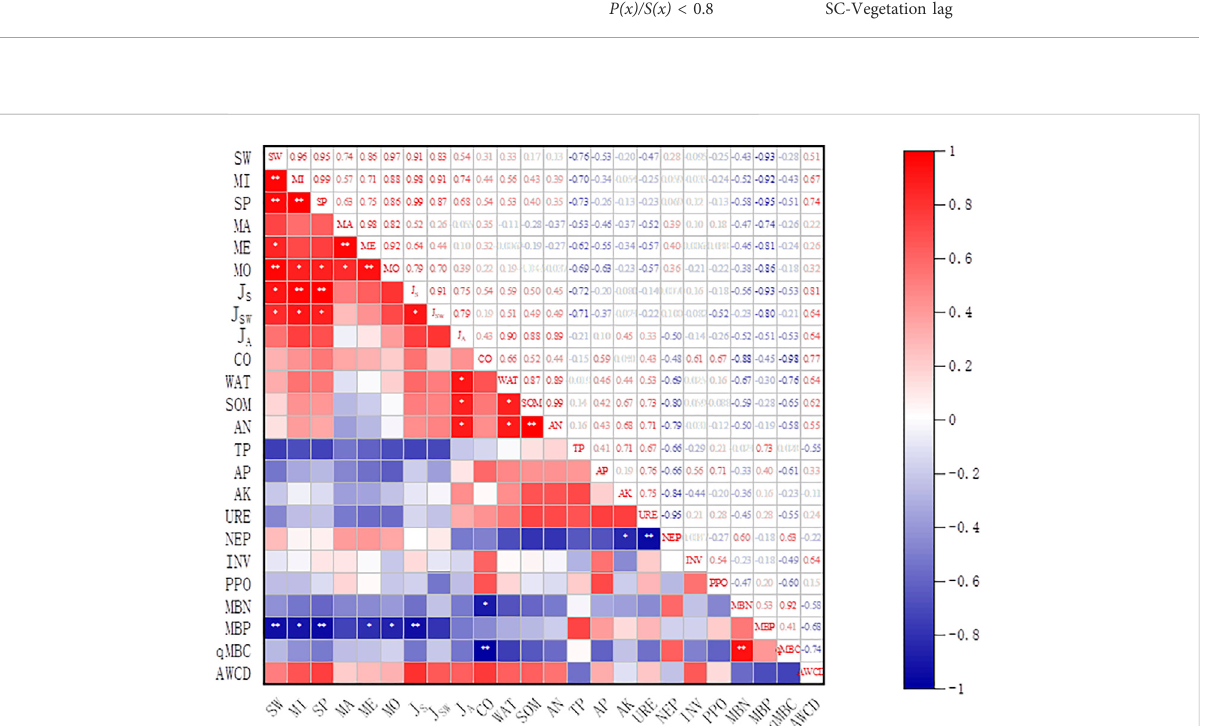
FIGURE 2 Correlation between indicators of habitat materials and vegetation system under different vegetation restoration models. Notes: * indicates signi fi cant correlation ( p < 0.05), and ** indicates highly signi fi cant correlation ( p <